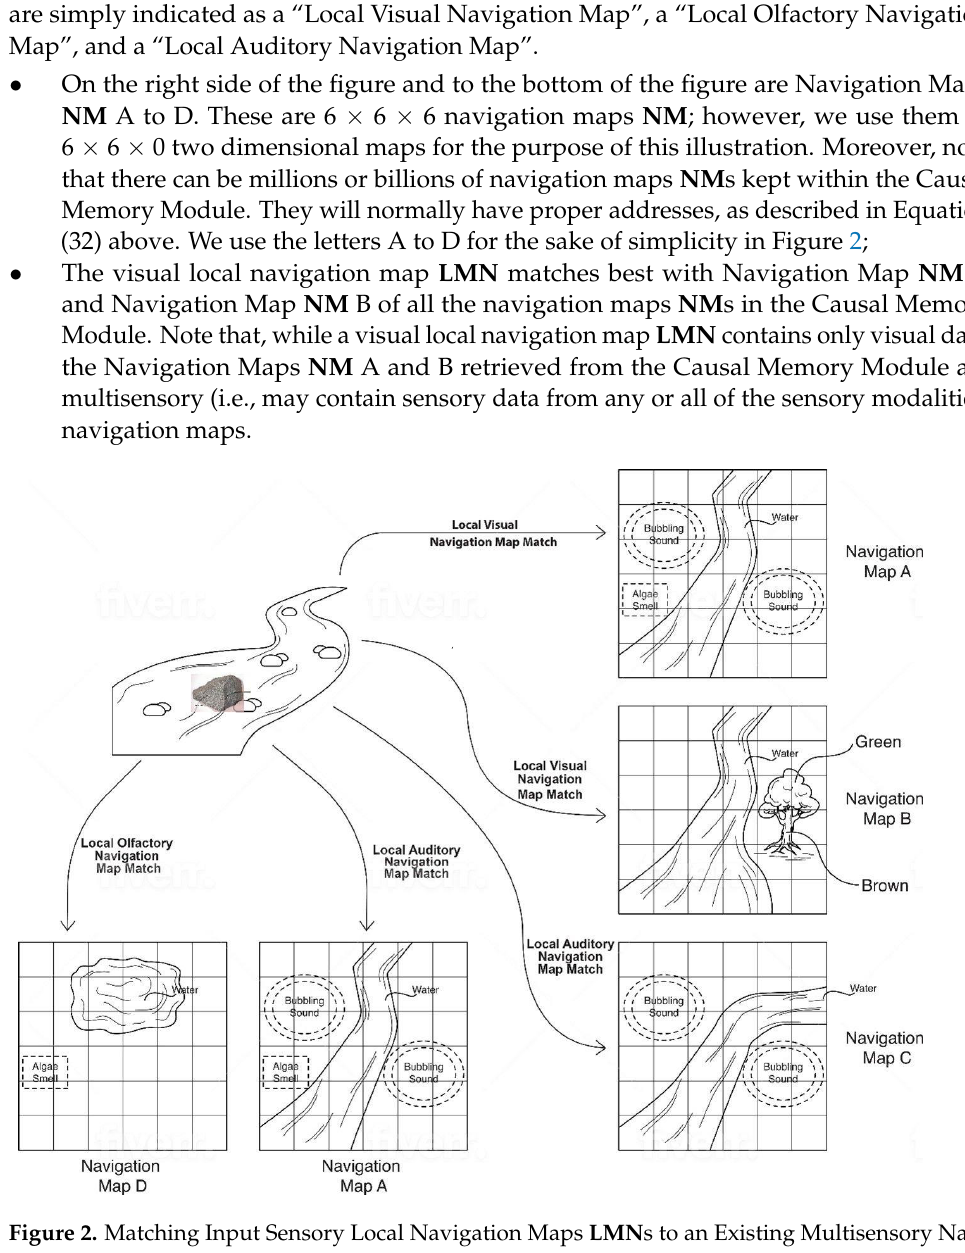
Figure 3 . Different features from different sensory modalities of the sensory scene are here bound to WNM (working navigation map), which represents a river. Note a moving object on the river. A motion prediction vector represents the movement of the object. The larger rock in the river is rep- resented in the navigation map as well. The updated navigation map is now termed the working navigation map WNM’ . 2.9. Navigation Module Complex: Navigation Module As noted above, some navigation maps are actually more dedicated to performing operations on other navigation maps, and these maps are termed “learned primitives” and “instinctive primitives.” Primitives can be thought of as being similar to productions of other cognitive architectures or as algorithms of more traditional computer systems. However, primitives are themselves part of navigation maps, and primitives operate on other navigation maps.